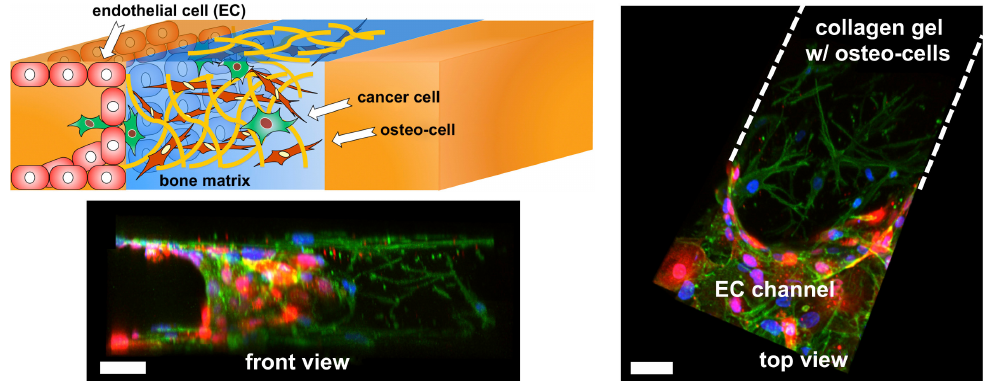
Figure 4. On-chip device modeling breast cancer metastasis in the bone tissue. Microfluidic device modeling breast cancer cell extravasation towards the bone tissue. Tri-culture system where osteo- differentiated mesenchymal stem cells created a bone-like environment by conditioning a collagen hydrogel. After seeding a monolayer of endothelial cells on the edge of the collagen hydrogel, breast cancer cells were introduced and their extravasation ability was assessed. Scale bar, 50 µm. Image adapted from [97]. Images were taken with permission from